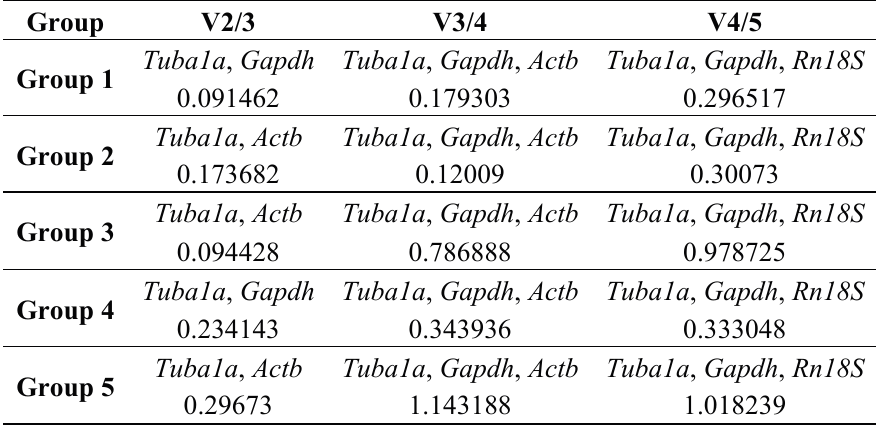
Table 4. Pairwise variation coefficient calculated for sequential normalization factors for each of the five experimental groups. Pairwise variation coefficient of the most stable genes was calculated followed by sequential inclusion of less stable genes. Group 1, branching morphogenesis (E11.5–E16.5); Group 2, differentiation, canalicular and saccular (E16.5–P5); Group 3, prenatal development (E11.5–E18.5); Group 4, postnatal development (P1–P28); Group 5, all